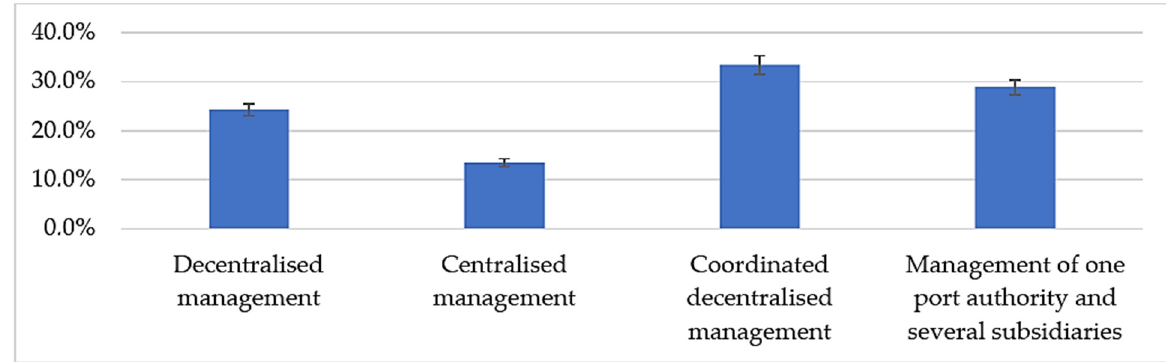
Figure 5. Graphic representation of results for the evaluated alternatives—AHP method.